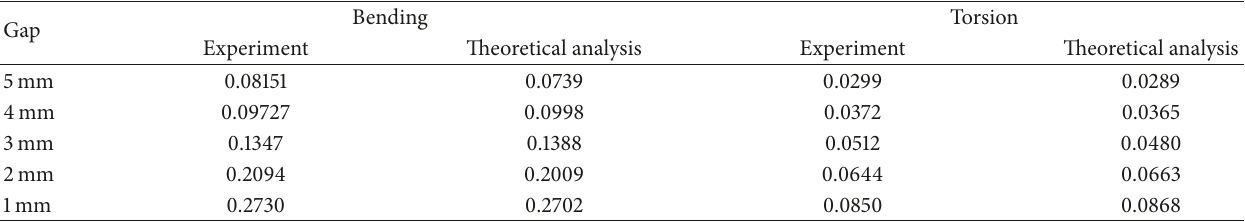
Table 3: Comparison of damping coefficients for the gap change between experiments and theoretical